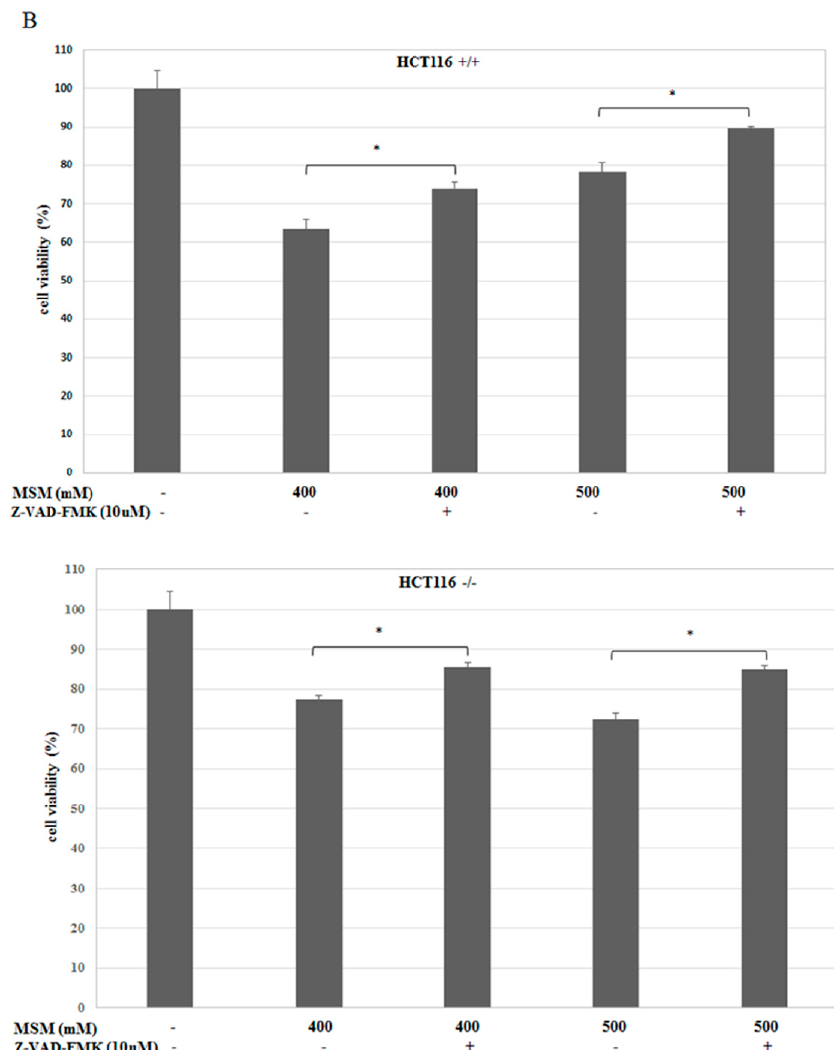
Figure 3. Effects of MSM on caspase-3 activity in HCT-116 p53 +/+ and p53 − / − colon cancer cells. Cells were treated with or without MSM (400 and 500 mM) for 24 h and cytosolic extracts of cells were used for caspase-3 activity. ( A ) Caspase-3 enzyme activity increased significantly after MSM treatment. The presense of Z-VAD-fmk (caspase-3 inhibitor) before 400 mM and 500 mM MSM treament decreased caspase-3 activity in both HCT-116 p53 +/+ and p53 − / − colon cancer cells; ( B ) cells were incubated with MSM (400 and 500 mM) in the absence and presence of Z-VAD-fmk. Cell viability of HCT-116 p53 +/+ and p53 − / − colon cancer cells increased in the presence of Z-VAD-fmk (* denotes a significant difference from the control group, p < 0.05).